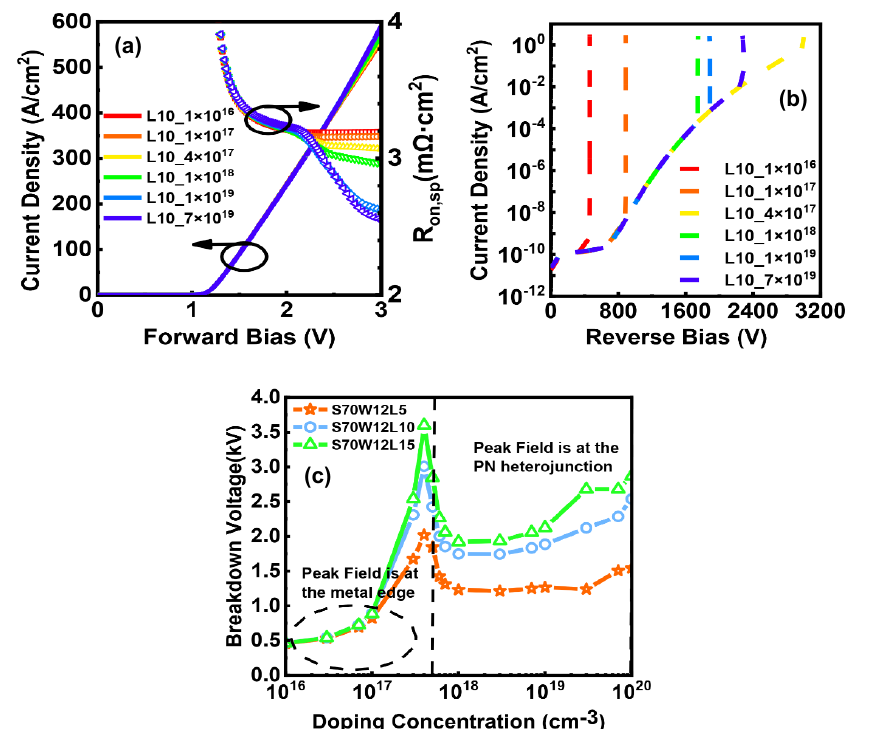
Figure 10. ( a ) Forward J-V and ( b ) reverse J-V characteristics of the Ga 2 O 3 SBD with different doping concentrations of the p-NiO GRs, when the width of GR is 12 µ m. ( c ) Breakdown voltage versus p-NiO GR doping concentration with 12 µ m of GR width for different drift layer thicknesses. In summary, the forward electrical characteristics and reverse leakage current of the SBD with GRs are related to the width of the GR and the thickness of the drift layer, and the doping concentration of the GR, while its BV is related to the doping concentration of the GR and the thickness of the drift layer. Proper doping concentration of GRs and drift layer thickness can make SBD with GRs obtain ultra ‐ high BV while keeping a small R on,sp . The optimized BV/R on,sp is simulated to be 3006 V/3.07 m Ω∙ cm 2 , translating to a PFOM = BV 2 /R on,sp = 2.94 GW/cm 2 . 3.3. HJBS Diode JBS diode is a typical SBD structure, which is used to increase BV and reduce reverse leakage current while maintaining a low V on . In this part, we explore the use of p ‐ NiO as the p ‐ type material to construct Ga 2 O 3 HJBS. There are 6 fins under the anode and the drift layer thickness is 10 μ m. Considering the best performance of Ga 2 O 3 SBD with NiO GRs when the NiO doping concentration is 4 × 10 17 cm − 3 , we compare HJBS with NiO doping concentration of 1 × 10 18 cm − 3 and 4 × 10 17 cm − 3 . Meanwhile, we simulated three HJBS diode configurations with different fin widths and spacings: (1) the width of NiO fin is 8 μ m, the Ga 2 O 3 space is 2 μ m; (2) the width of NiO fin is 8 μ m, the Ga 2 O 3 space is 3 μ m; (3) the width of NiO fin is 5 μ m, the Ga 2 O 3 space is 6 μ m. The forward J ‐ V characteristics of HJBS are affected by the doping concentration of the p ‐ type region and the total width of NiO, as shown in Figure 11a. The V on of the HJBS with different fin width, spacing, and doping concentration is still 1.1 V, which is the same as the V on of SBD with a 10 ‐μ m ‐ thick drift layer. The R on,sp of HJBS with the NiO doping concentration of 1 × 10 18 cm − 3 is extracted to be 3.32 m Ω∙ cm 2 , 3.29 m Ω∙ cm 2 , and 2.99